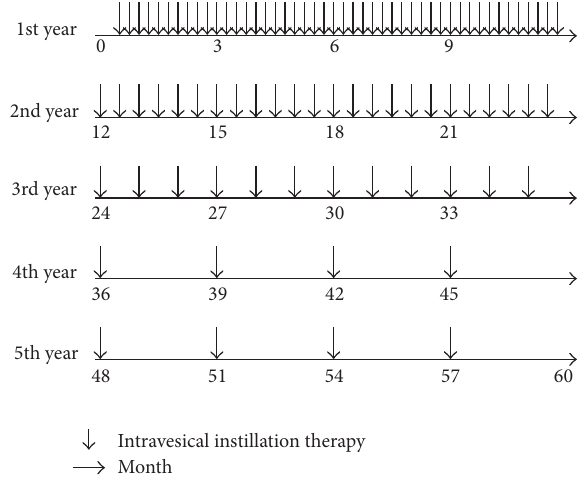
Figure 1: Instillation group was treated using long-term intravesical instillation of 30 mg of epirubicin plus 200 mg of Ara-C dissolved in 20 mL of physiological